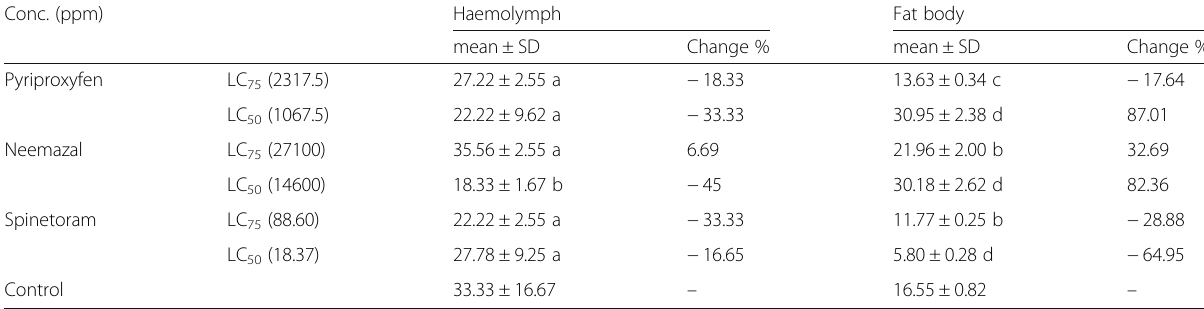
Conc . concentration; mean±SD followed with the letter (a): is not significantly different ( P >0.05), (b): significant ( P <0.05), (c): very significant ( P <0.01), (d): extremely significant ( P